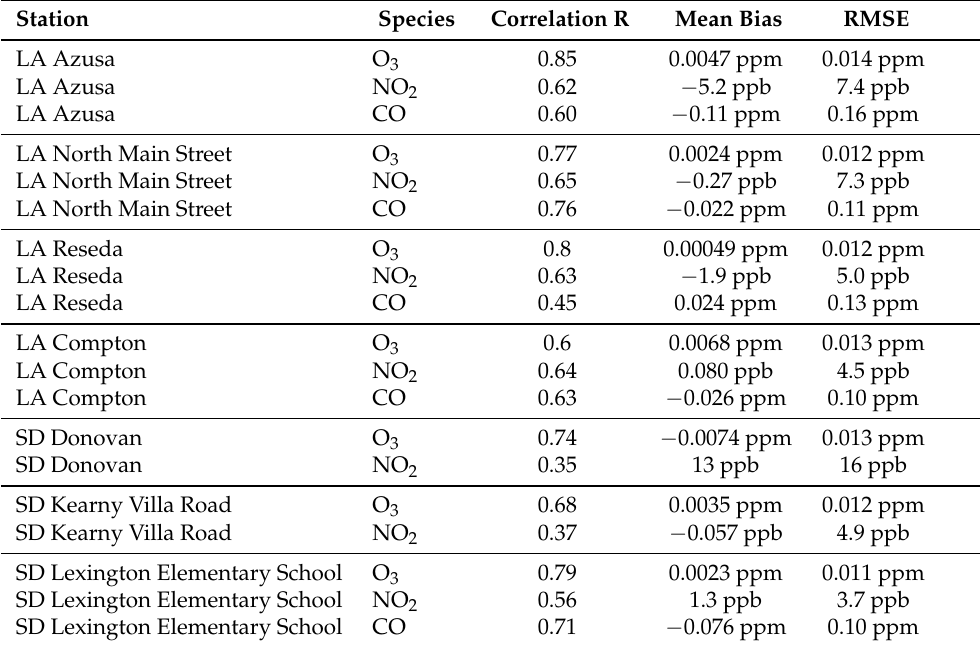
Table 3. Statistics of observed and simulated concentrations of O 3 , NO 2 , and CO from 30 June–13 July 2018.